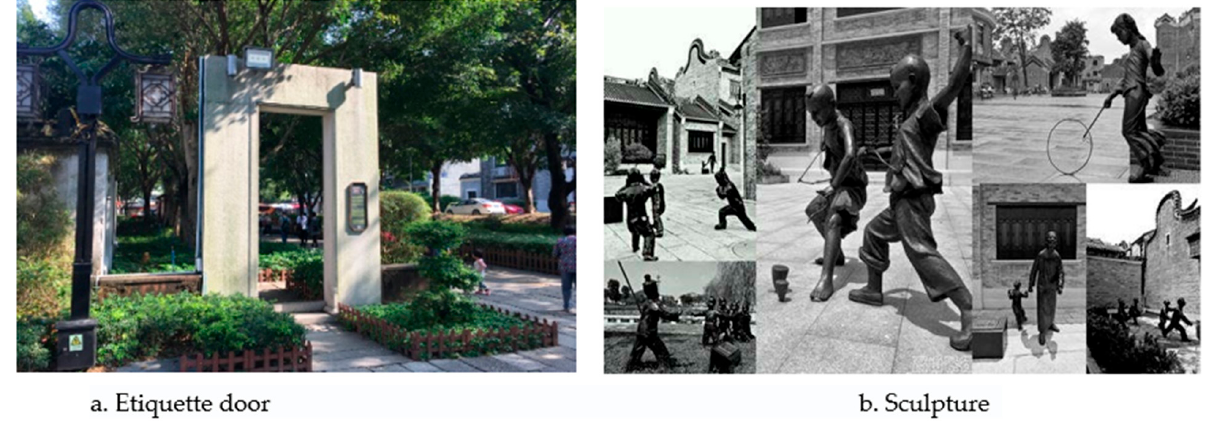
Figure 17. Diversified media narrative. (Source: the authors).